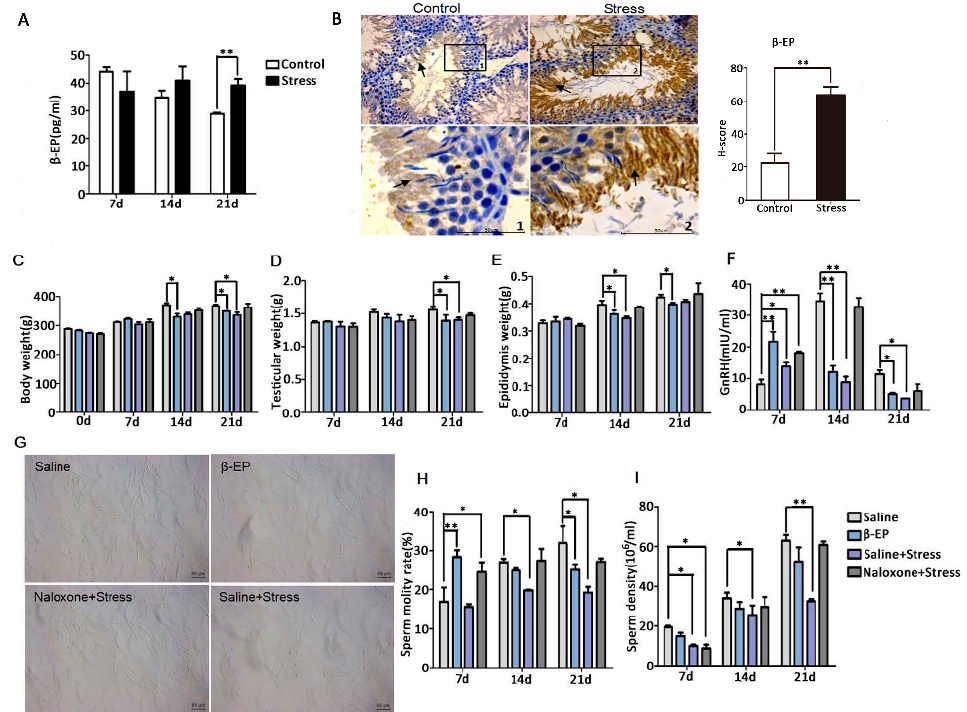
Figure 2. Reproductive dysfunction is associated with PS-induced β -EP elevation. ( A ) Elevated serum β -EP concentration in PS rats vs. controls as measured by ELISA. ( B ) Elevated β -EP in extracellular region in the lumen of the seminiferous tubules (black arrow) in testicular tissue of PS rats as measured by immunohistochemistry. Testicular tissue sections and partially magnify were displayed. Bar = 50 µ m. The H-score demonstrated that β -EP was significantly higher in the stress group vs. the control group. ( C – E ) Reduced body, testicular, and epididymis weights of rats injected with β -EP. ( F ) Reduced serum GnRH level in β -EP-injected rats. ( G ) Temporary slide microscopy showing reduced sperm count in cauda epididymis of β -EP-injected rats. Bar = 50 µ m. ( H , I ) Reduced sperm motility and density in β -EP-injected rats. All effects were reversed by naloxone.